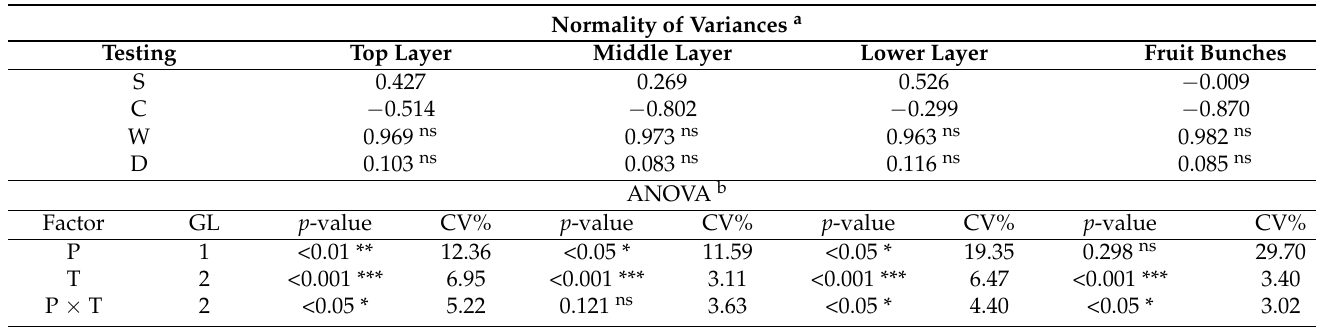
Table 6. Normality and analysis of variance (ANOVA) for volumetric median diameter at different plant layers and clusters of papaya